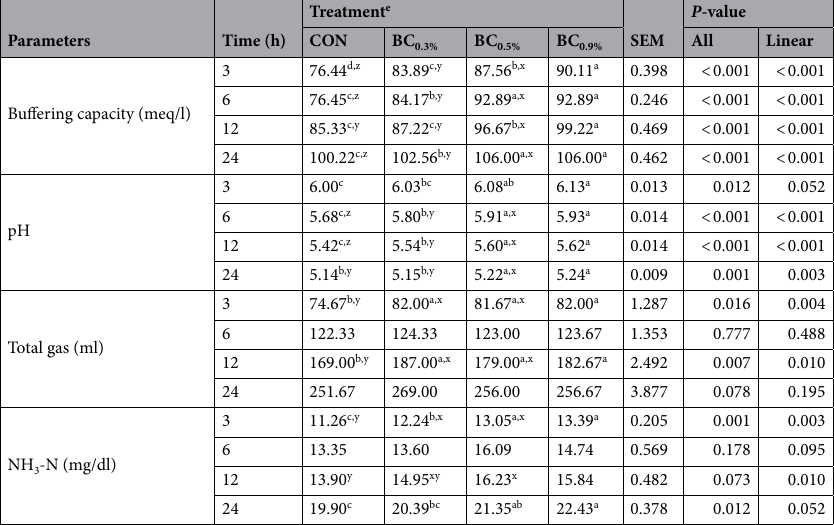
Table 1. Effect of different buffering capacity concentrations on in vitro rumen fermentation parameters at 3, 6, 12 and 24 h. SEM, standard error of the mean. e CON (no buffer added); BC 0.3% (0.3% buffer); BC 0.5% (0.5% buffer); BC 0.9% (0.9% buffer). a–d Means with different superscripts in a row differ significantly ( P < 0.05); x,y,z Means within a row indicate linear effect among CON, BC 0.3% , and BC 0.5% ( P < 0.05).